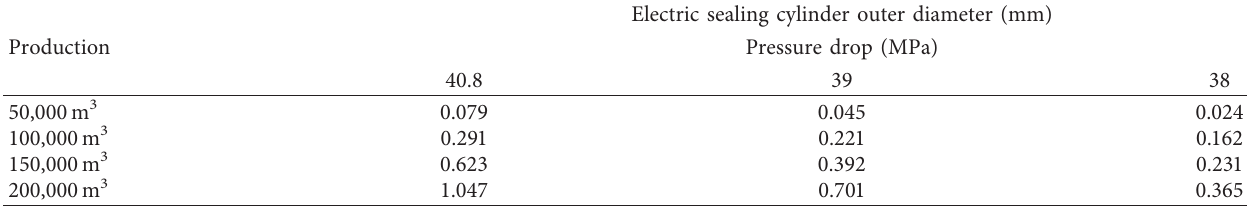
Table 2: Annular throttling pressure drop under different outer diameters of electric sealing cylinder.